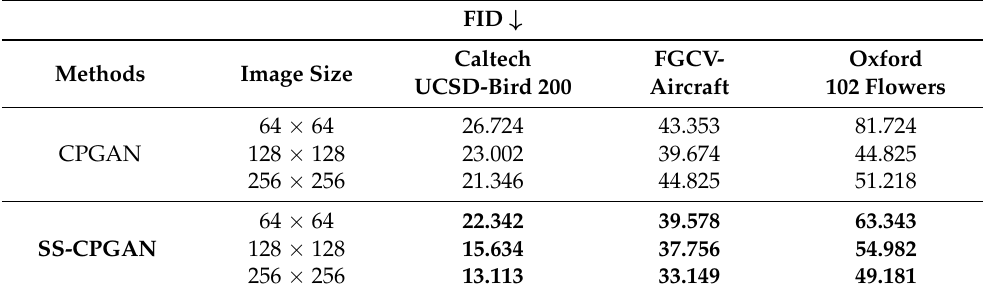
Table 2. FID comparison of the proposed method with the baseline CPGAN